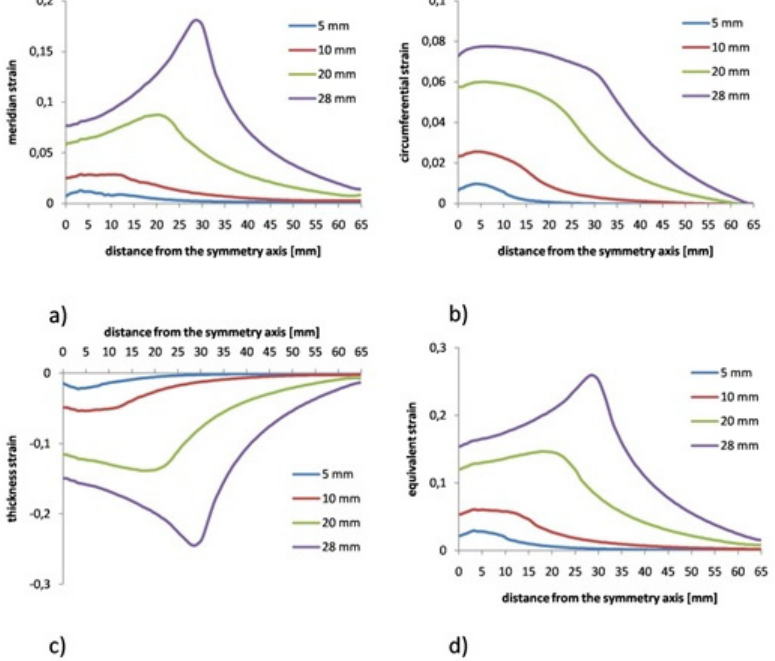
Figure 4. Distribution of the main strains and equivalent strain during the stretching process in friction conditions with a friction coefficient µ = 0.1 due to FEM: ( a ) meridian strain; ( b ) circumferential strain; ( c ) thickness strain; ( d ) equivalent strain.